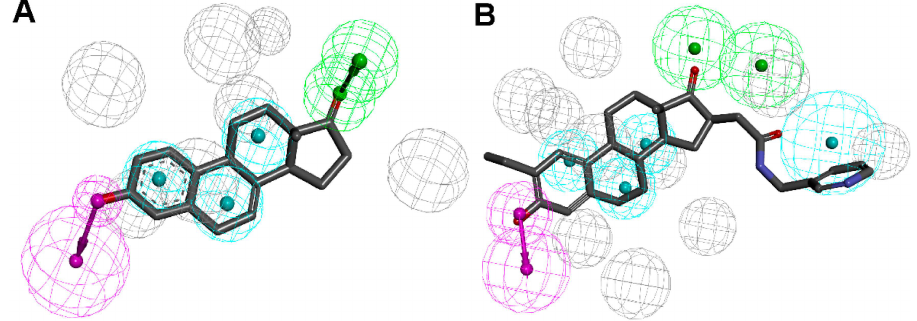
Figure 13. ( A ) 17 β -HSD1 model based on the equilin crystal structure (PDB entry 1EQU [5]); ( B ) The potent inhibitor STX 1040 maps the hybrid 17 β -HSD1 pharmacophore model